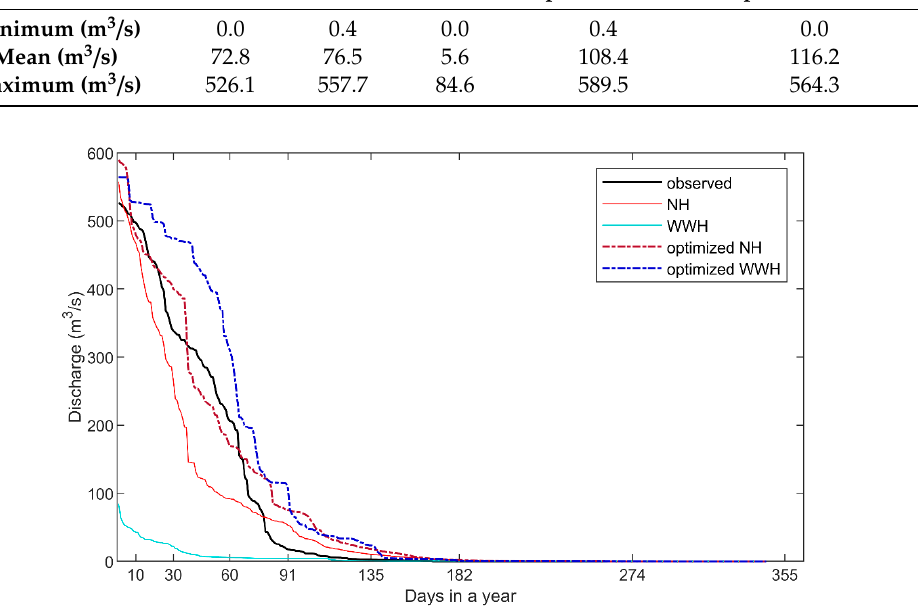
Figure 4. Flow duration curve of the Sirba River at Garbey Kourou in the validation year 2019. Observed flow, NH and WWH 5-day forecasts before and after the optimization.